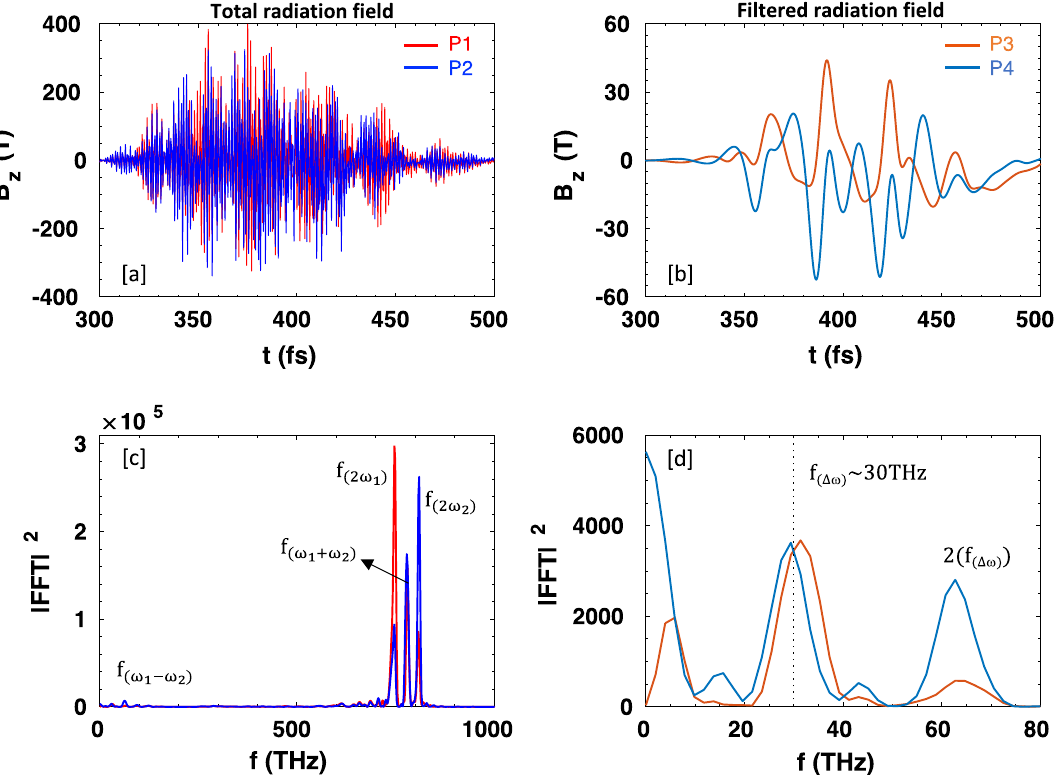
Figure 2. Temporal profiles of ( a ) total emitted radiation, ( b ) filtered beat-frequency radiation in vacuum, measured by the virtual point probes; P1, P2, P3, and P4, located 10 µ m away from the emission spot, and ( c – d ) their corresponding power